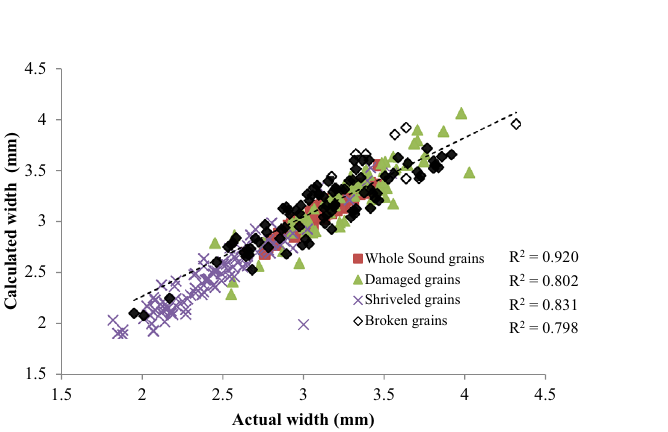
Figure 4. Relationship between the length of refractions measured with caliper and the calculated from image.